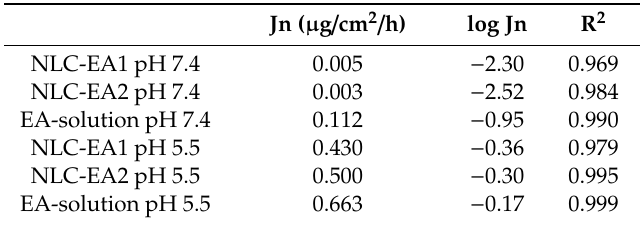
Figure 3. In vitro diffusion kinetics of EA from DMSO solution (circles) or NLC-EA1 (squares) and NLC-EA2 (diamonds) as determined by Franz cells associated to nylon membranes. Experiments were conducted in phosphate buffer at different pH, namely 7.4 (closed symbols) and 5.5 (open symbols). Data are the mean of four independent experiments ± s.d. Table 6. In vitro diffusion coefficients of EA.